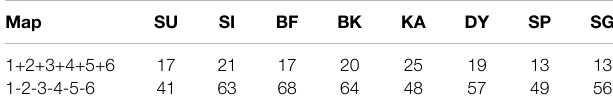
TABLE 6 | ATE (mm) comparison with and without graph reduction.